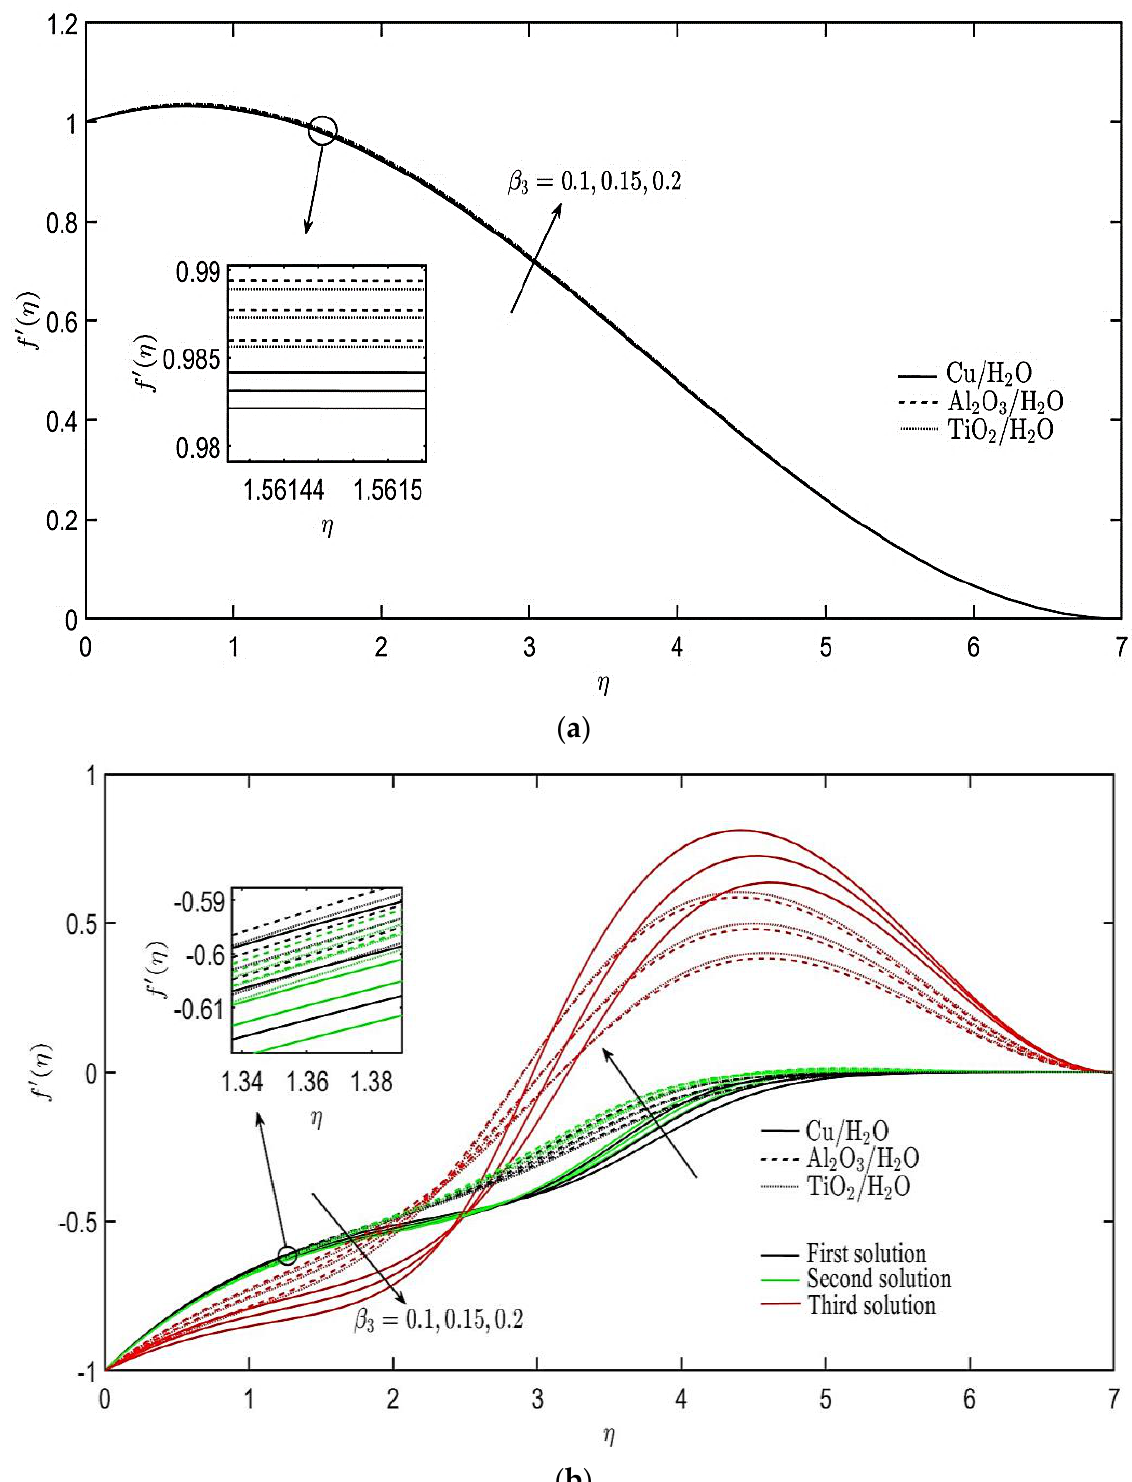
Figure 11. Effect of fluid retardation time parameter on velocity profiles for: ( a ) Stretching case; ( b ) Shrinking case.